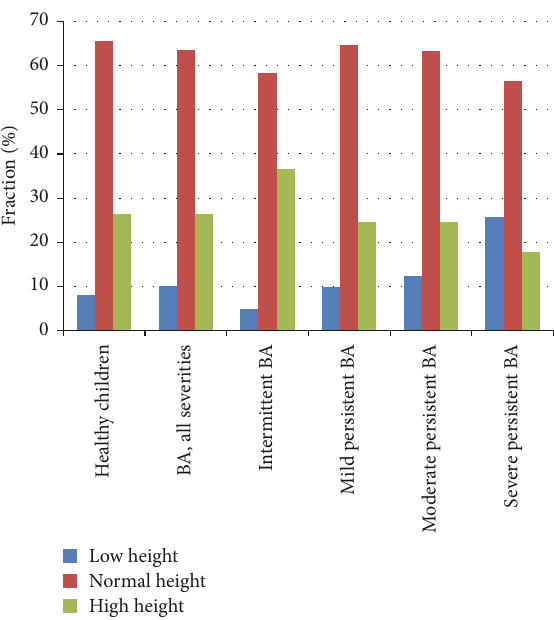
Figure 1: Physical development of children with different BA severity.